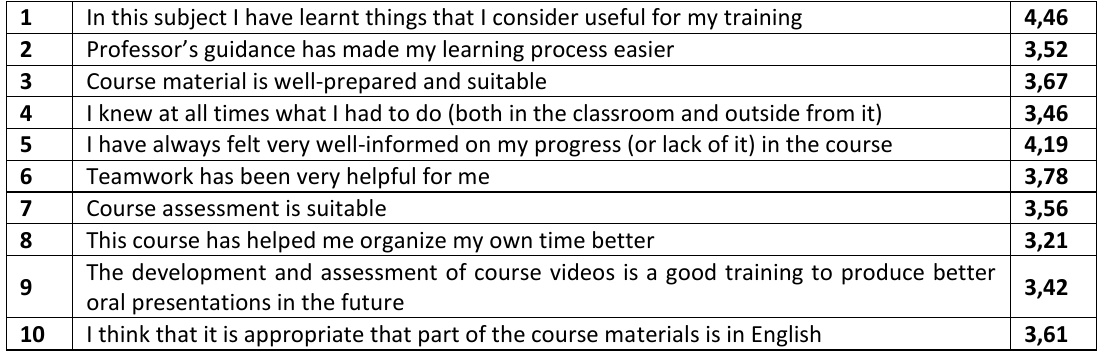
Figure 5: Results from the satisfaction questionnaire that students fill in at the end of the course. They correspond to IC subject, academic course 2009-2010, first term. In total, 52 students answered (out of 81 enrollments) This data (especially, question 5) indicate that the follow-up and feedback processes here described are effective according to students’